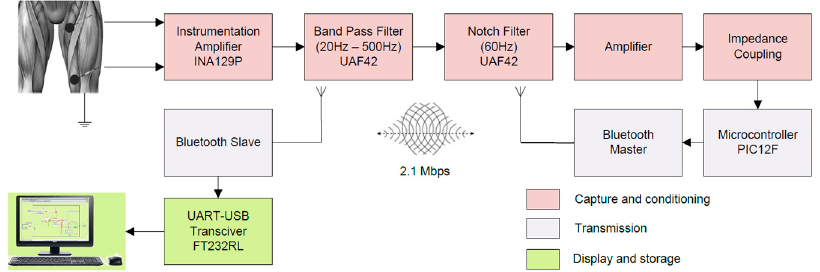
Figure 1. General block diagram of the EMG signals system.